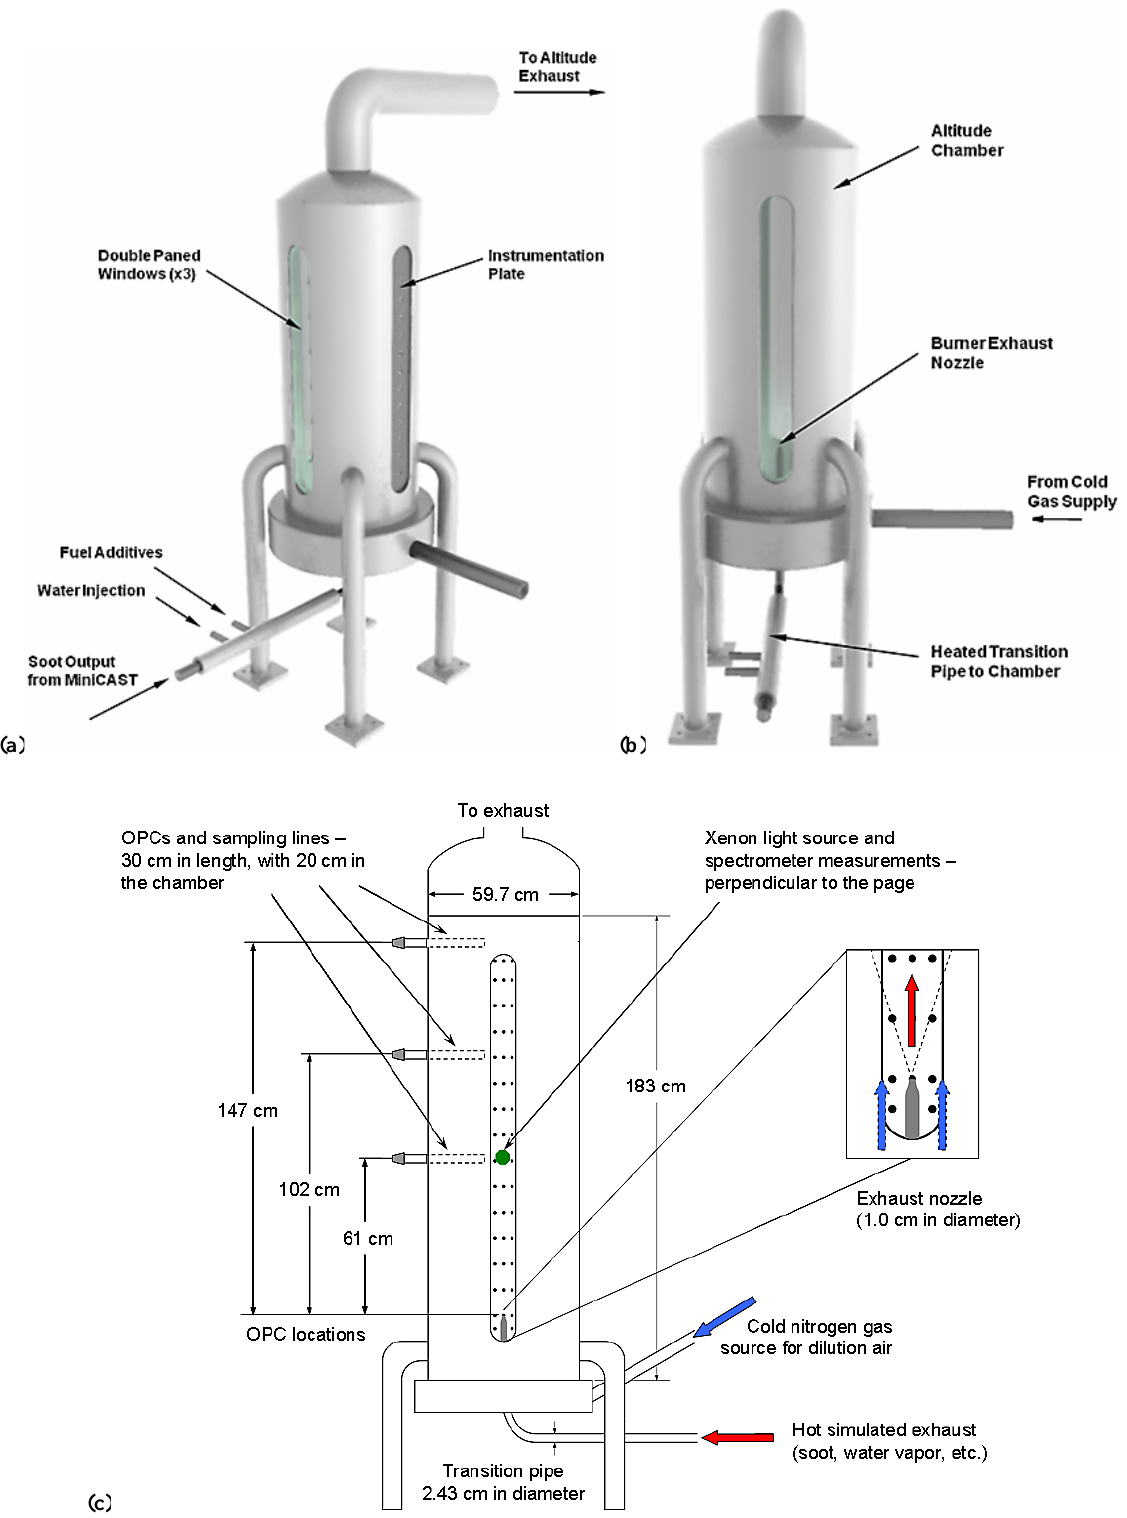
Fig. 1. PAL altitude simulation chamber: (a) isometric view, (b) front view, and (c) schematic representation of the PAL pipes and sampling